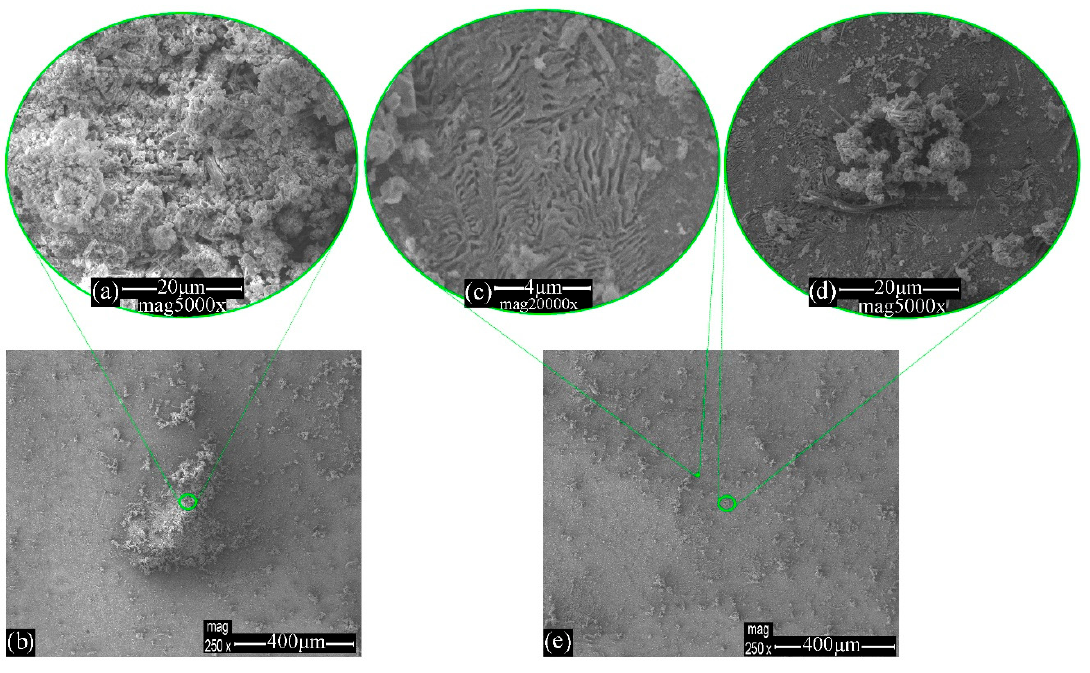
Figure 7. SEM images of mild steel immersed in 3.5 wt % NaCl for 96 h in the absence of inhibitors.